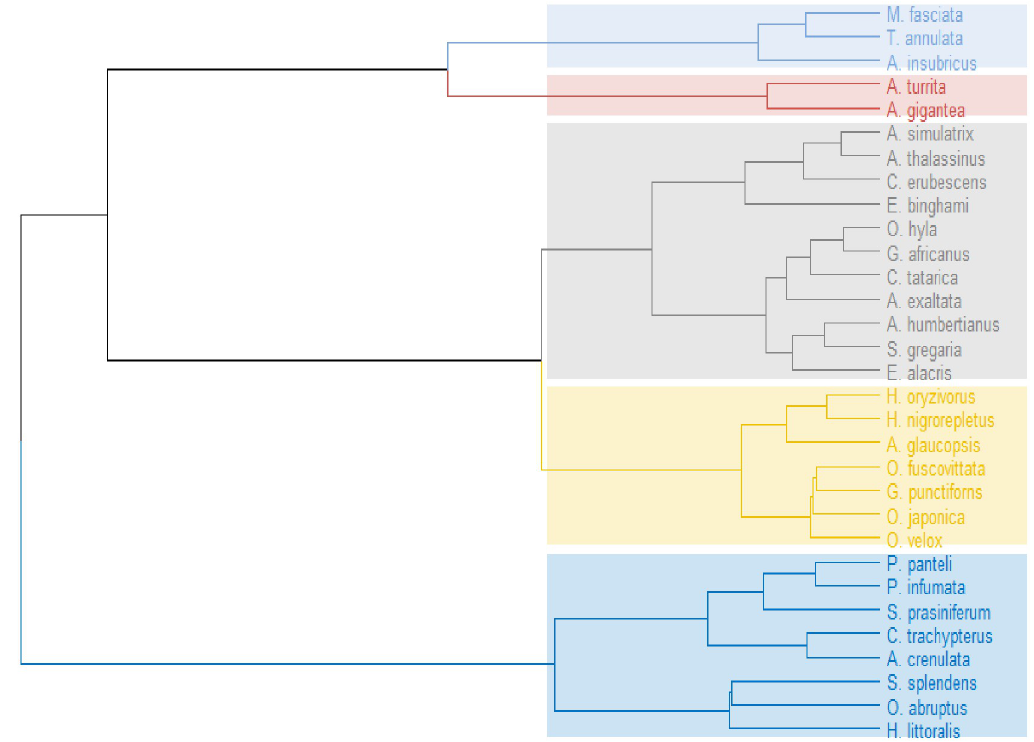
Fig 5. Hierarchical cluster relationship among 31 acridid species based on dose-response mortality values. The species are grouped into five clusters (color sheds) based on their differential mortality exhibitions (response). Each frond of the dendrogram corresponds to objects (species) similar to each other, merged into branches, and fused at a higher height. The higher the height of the fusion, the less similar the species are, and the less similar the species are, the higher the fusion height.